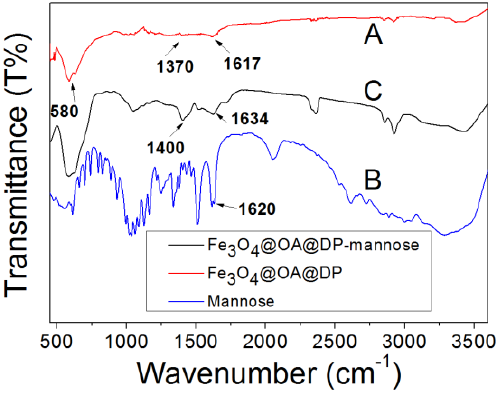
Figure 1. FTIR spectra of (A) Fe 3 O 4 @OA@DP, (B) mannose, and (C) Fe 3 O 4 @OA@DP – mannose.